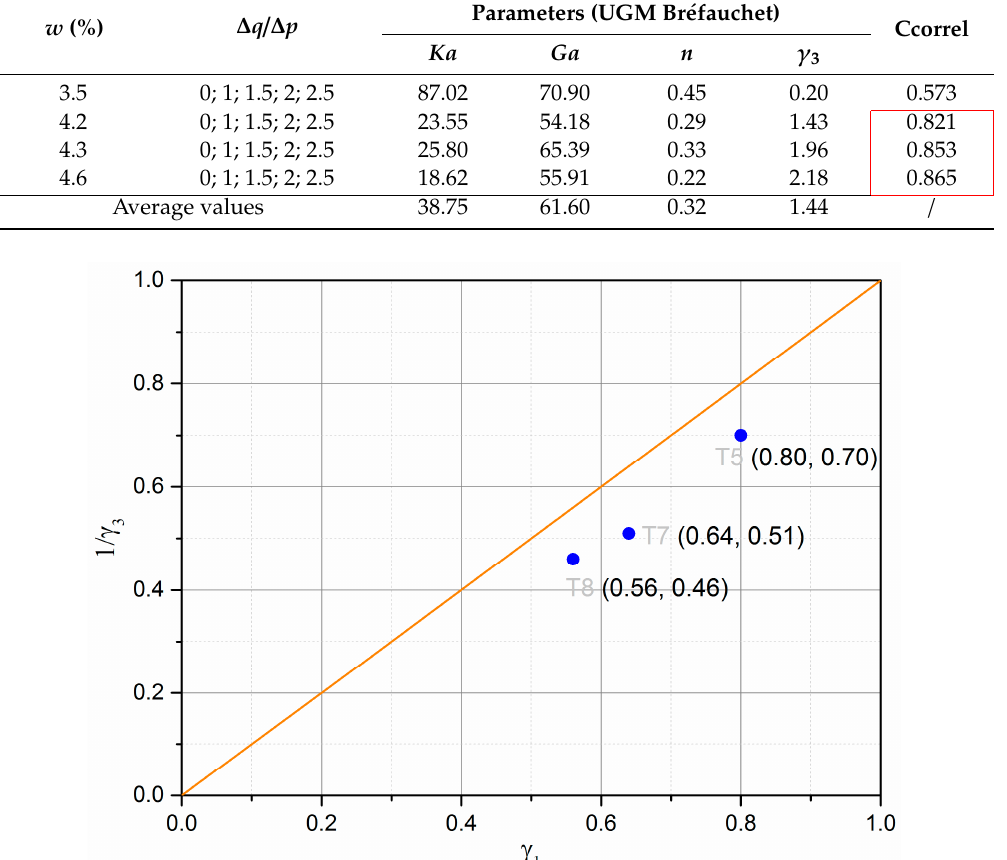
Table 6. Parameter optimization of Equations(12)–(15) for UGM Bréfauchet with γ 3